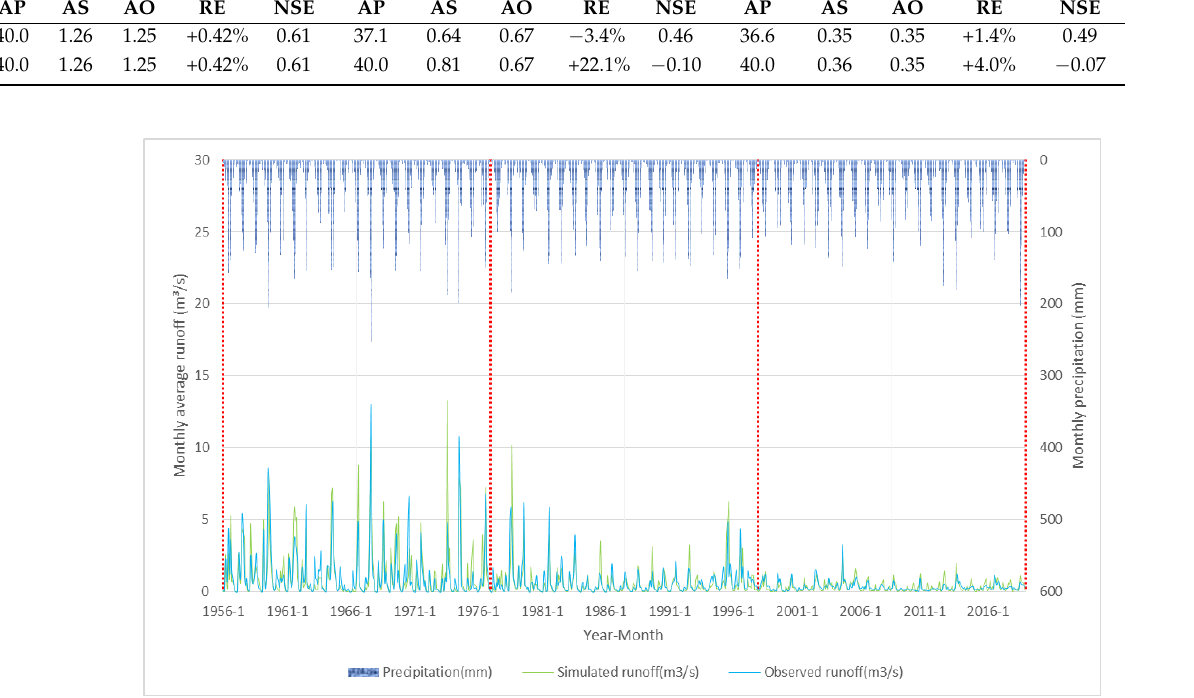
Figure 14. Simulated results of S3